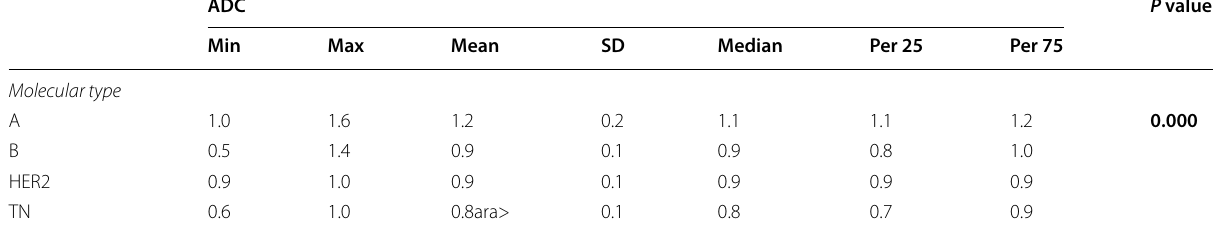
Table 4 Comparison of ADC regarding molecular type